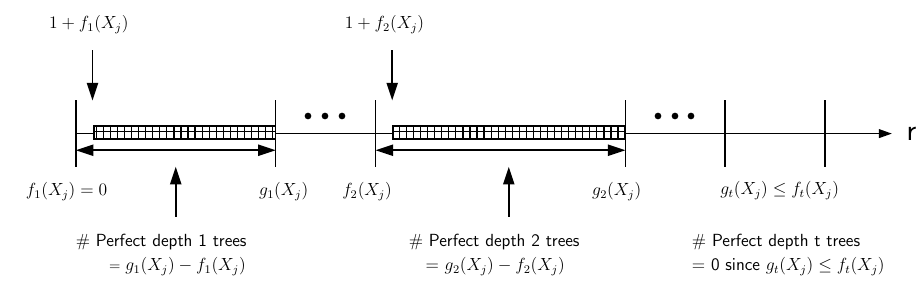
Figure 8: Illustration of finite depth trees in Trivium